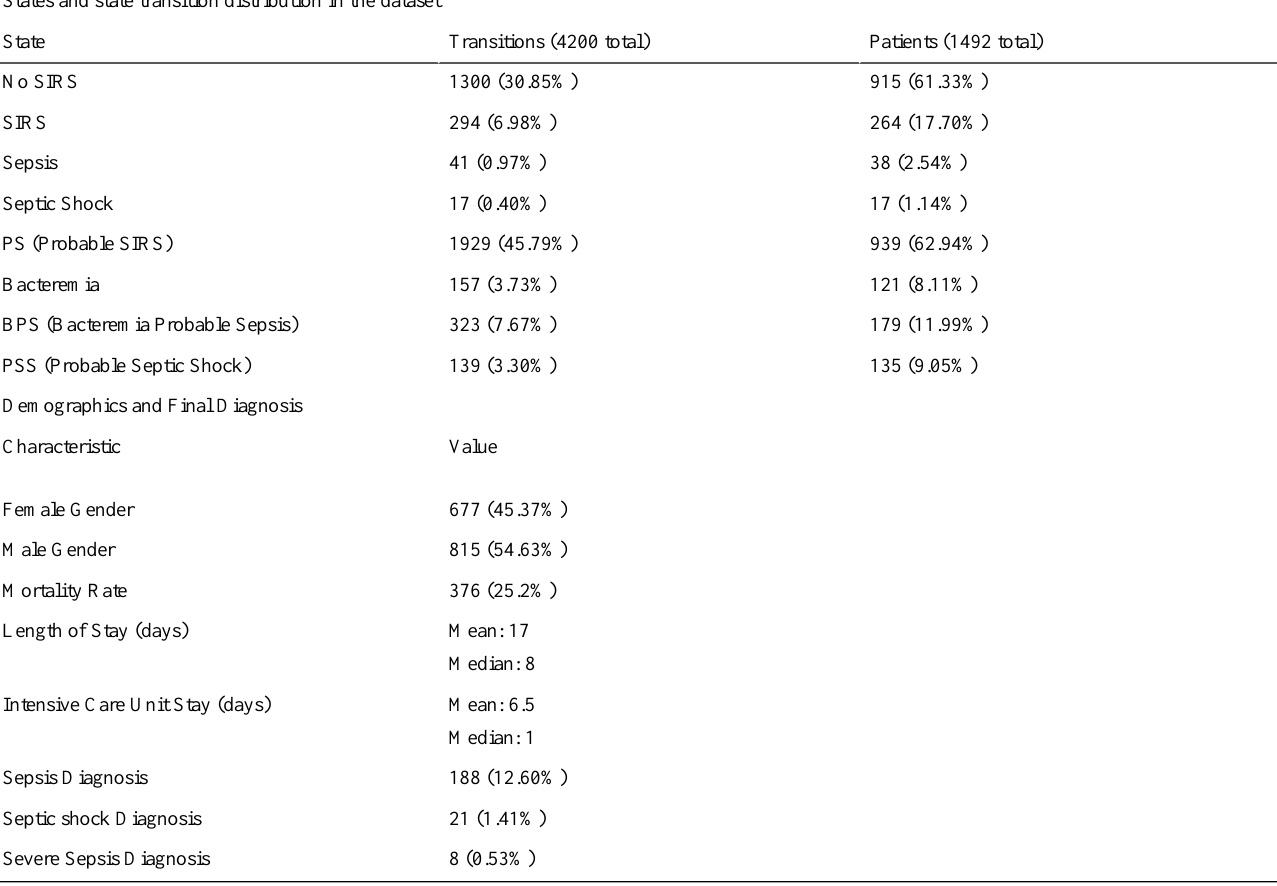
Table 1. Database